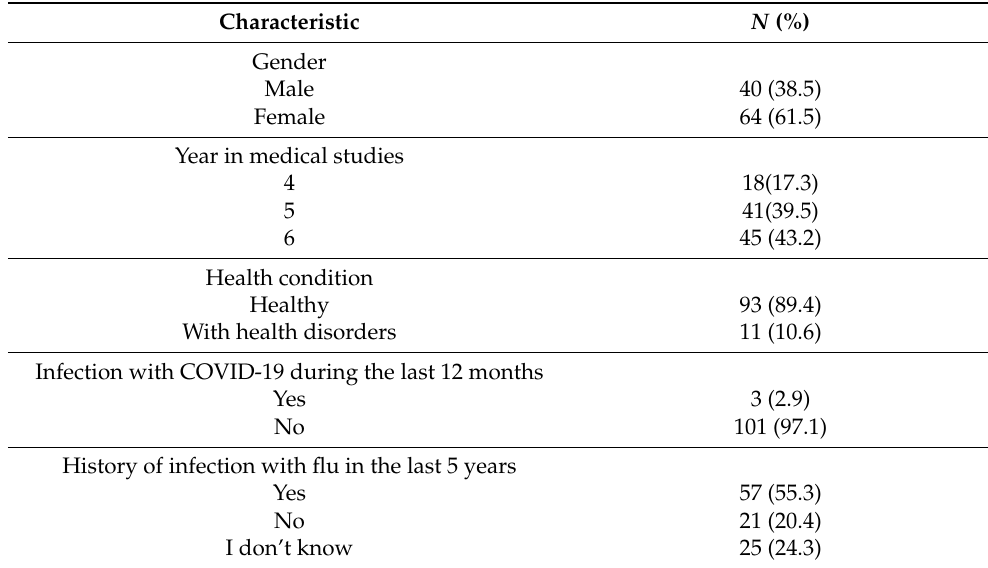
Table 1. Characteristics of study participants ( n =